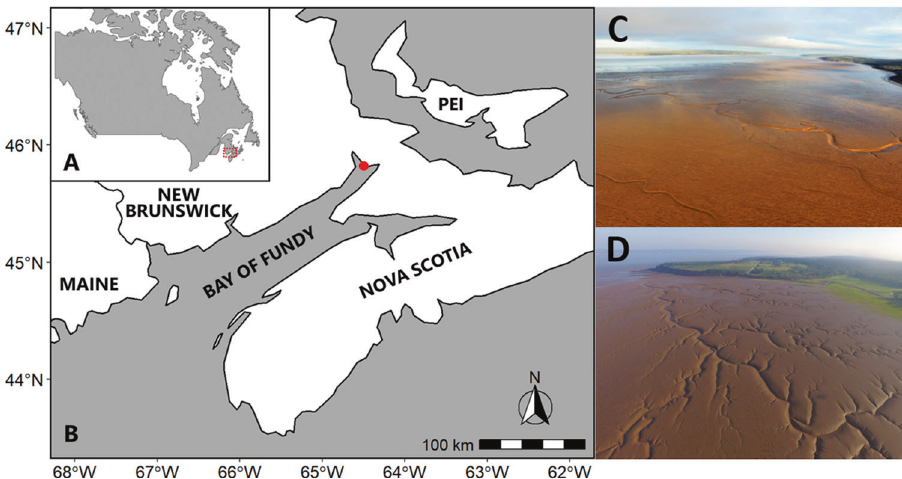
Fig. 1 Study sites in the Bay of Fundy, Canada. Location of ( A ) the Bay of Fundy and ( B ) the study sites, Grande Anse and Pecks Cove, in the upper Bay of Fundy (red dot). Aerial views of the intertidal mud fl at at both sites, with across-shore width of 2 – 3 km at ( C ) Grande Anse, and 0.8 – 1 km at ( D ) Pecks Cove. Photographs taken by G.S. Norris in summer